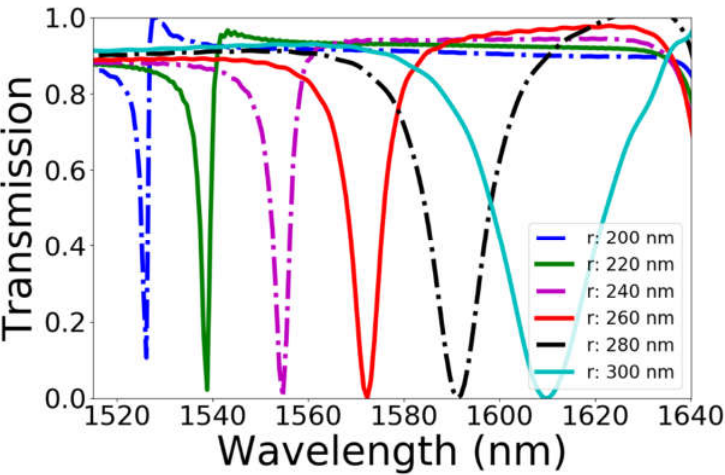
Figure 4. Transmission spectra of PhC-structure with hole-radii varied from 200 to 300 nm. A redshift along with an increase in the linewidth of the resonant modes can be seen.